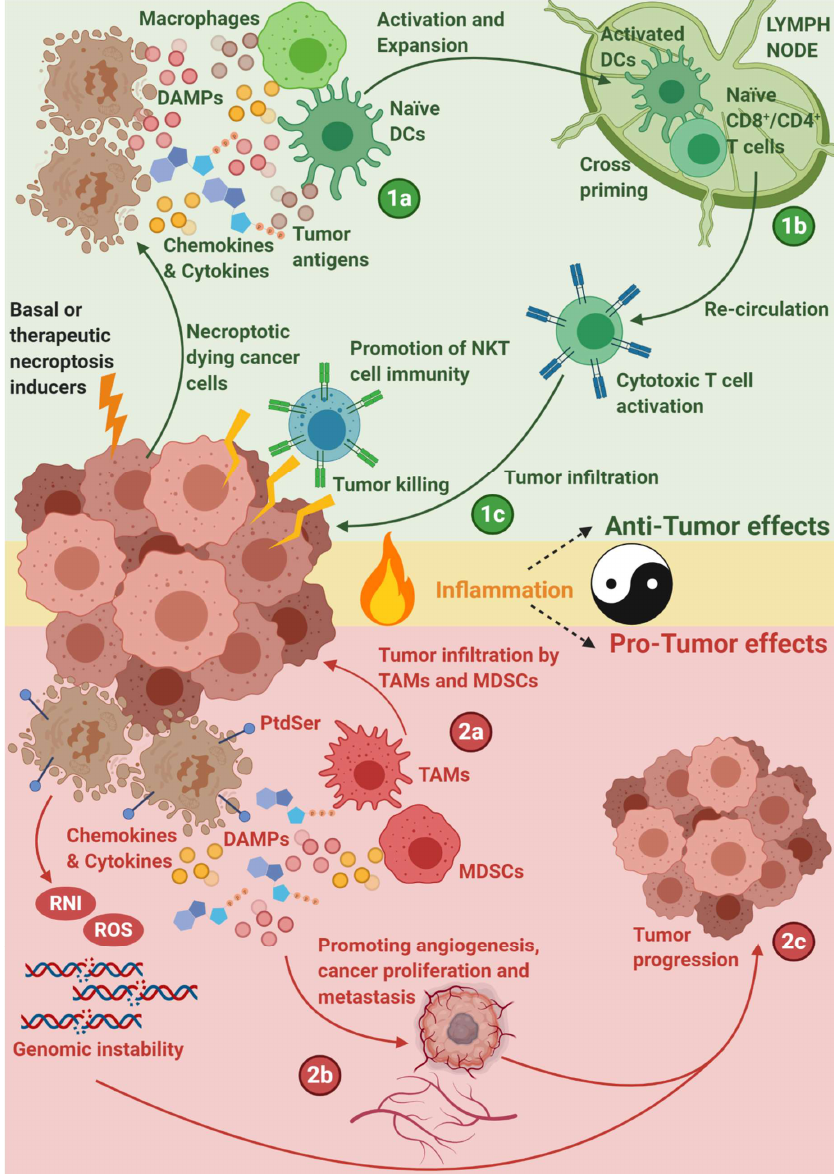
Figure 3. A schematic overview of necroptosis driven pro-tumor or anti-tumor immune responses. Necroptotic cancer cells release, damage-associated molecular patterns (DAMPs), chemokines, cytokines, and / or cancer antigens [and can also surface-expose phosphatidylserine (PtdSer)], which creates an inflammatory immune microenvironment that can either have anti-tumor or pro-tumor e ff ects. In the former scenario, necroptotic cancer cells may attract macrophages and naïve dendritic cells (DCs), that can get activated by necroptosis-derived DAMPs / cytokines (1a). Herein, activated DCs can migrate to the lymph nodes and cross-prime naïve CD8 + / CD4 + T cells for cancer antigens (1b). Upon such interactions, naïve T cells can di ff erentiate into e ff ector cytotoxic T cells and re-circulate out of the lymph nodes to infiltrate the tumor and kill the cancer cells. In parallel, RIPK3 can also induce the expression of cytokines that can activate natural killer T cells (NKT cells) which will also help in killing the cancer cells (1c). However, in the latter scenario, necroptotic cancer cells can also attract myeloid-derived suppressor cells (MDSC), and / or tumor-associated macrophages (TAM) which can cause tumor-associated immune suppression (2a). In parallel, cytokines released by necroptotic cancer cells can also promote angiogenesis, cancer proliferation and metastasis, combined with the release of reactive oxygen species (ROS) and reactive nitrogen intermediates (RNI) thereby facilitating genomic instability (2b), and further contributing toward tumor progression